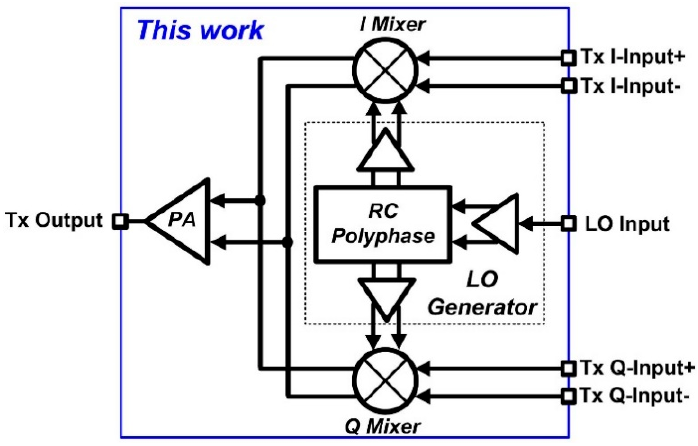
Figure 1. Block diagram of the proposed 24-GHz direct-conversion transmitter.